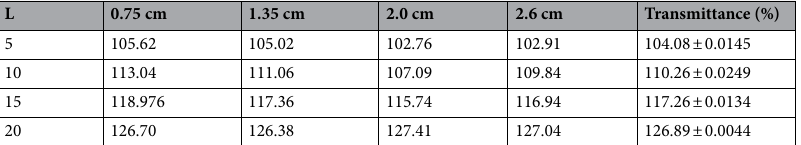
Table 2. Measurement results normalized by the measurement results of the Gaussian beam. Values are given in percentages relative to 100% of the transmitted Gaussian